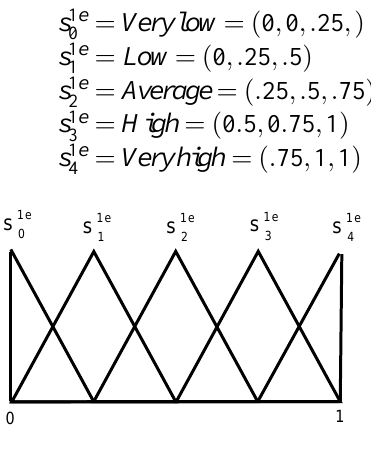
Fig. 7. The linguistic term set S 1